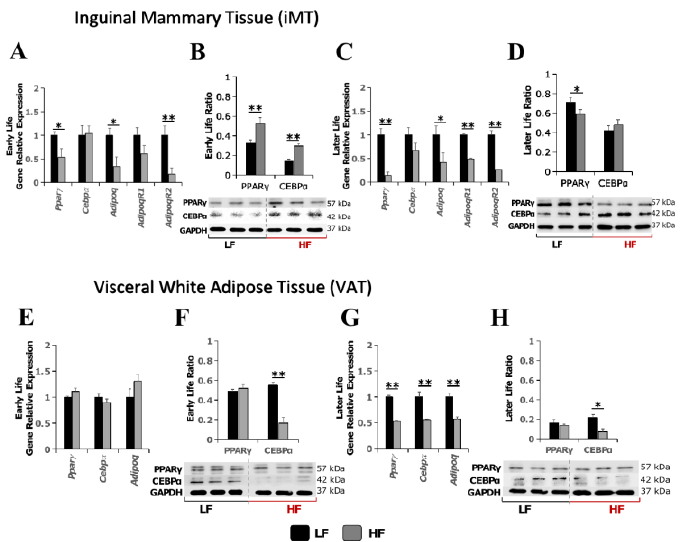
Figure 2. Effect of high-fat diet in early life on transcriptional and protein expressions of adipogenesis-related genes. ( A – D ) mRNA and protein expressions in inguinal mammary tissue in mice immediately after the 8 wk experimental HF/LF diet feeding (Early Life, A , B ) or later in young adulthood (Later Life, C , D ); ( E – H ) mRNA and protein expressions in visceral white adipose tissue in mice immediately after the 8 wk experimental HF/LF diet feeding (Early Life, E , F ) or later in young adulthood (Later Life, G , H ). Data are presented as mean ± SEM, n = 8 – 11/group. *: p < 0.05; **: p < 0.01.